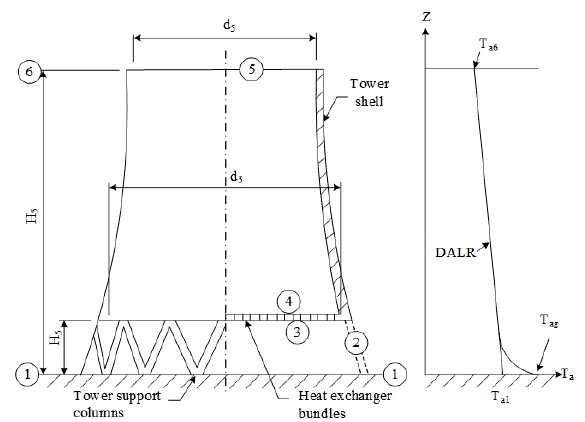
Figure 5. The distribution of heat exchangers in natural draft dry cooling tower (NDDCT).*DALR: Dry adiabatic lapse rate.